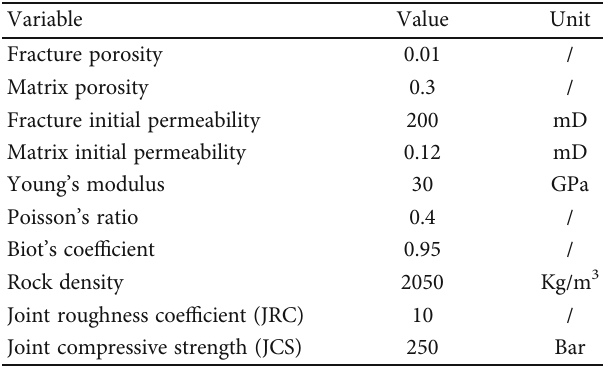
Figure 5: The geological model for Case 3. Table 2: Parameters for Case